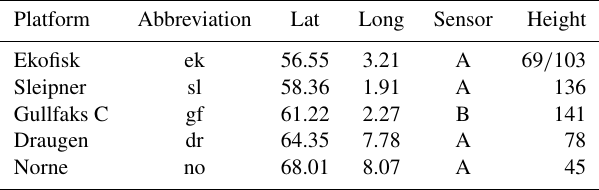
Table 1. Name, abbreviation, and location (in latitude and longi- tude) of each site, as well as the height (ma.s.l.) of the chosen wind sensor (A or B), giving the representative wind speed time series for each site. The chosen sensor at Ekofisk (ek) has two heights since the sensor was moved during the period